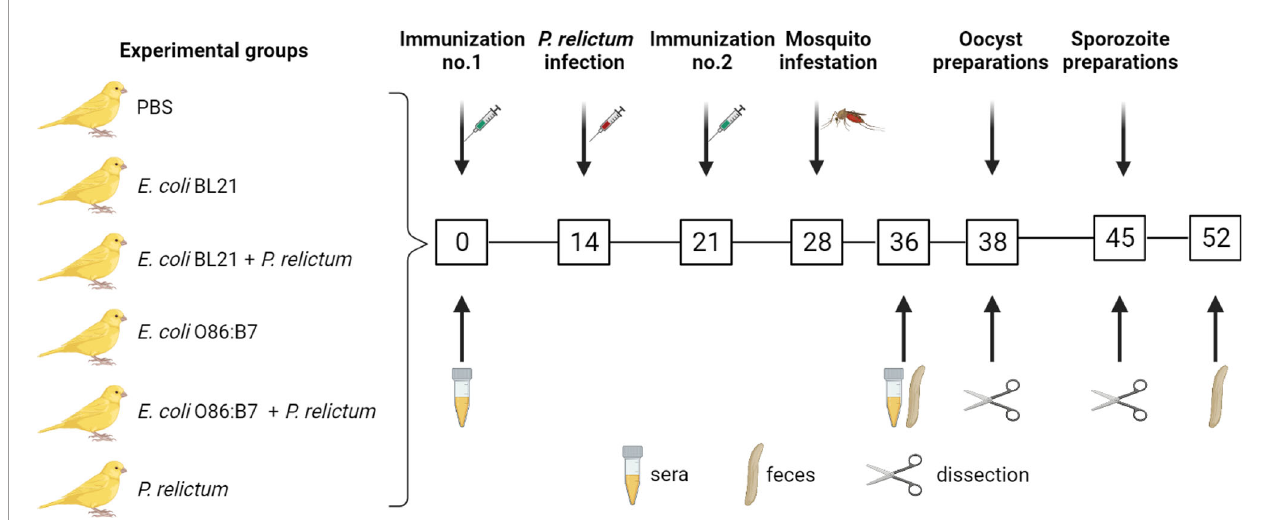
FIGURE 1 | Experimental design and sample collection. Canaries were immunized twice (at day 0 and day 21) with a live vaccine containing E. coli BL21 (n = 7) or E. coli O86:B7 (n =7) or with a mock vaccine (PBS) (n = 3). A group of canaries (n = 5) and part of the birds vaccinated with E. coli BL21 (n = 4) or E. coli O86:B7 (n = 4) were infected with P. relictum at day 14. The birds were used as donors to feed C. quinquefasciatus (n = 20-50 mosquitoes per bird). The midgut of mosquitoes was dissected for microbiota (day 38 and day 45) and oocyst (day 38) analysis and salivary glands for sporozoite (day 45) analysis. Bird sera (used for ELISA and immuno fl uorescence) and fecal (used for bird gut microbiota analysis) samples were collected at different time points as